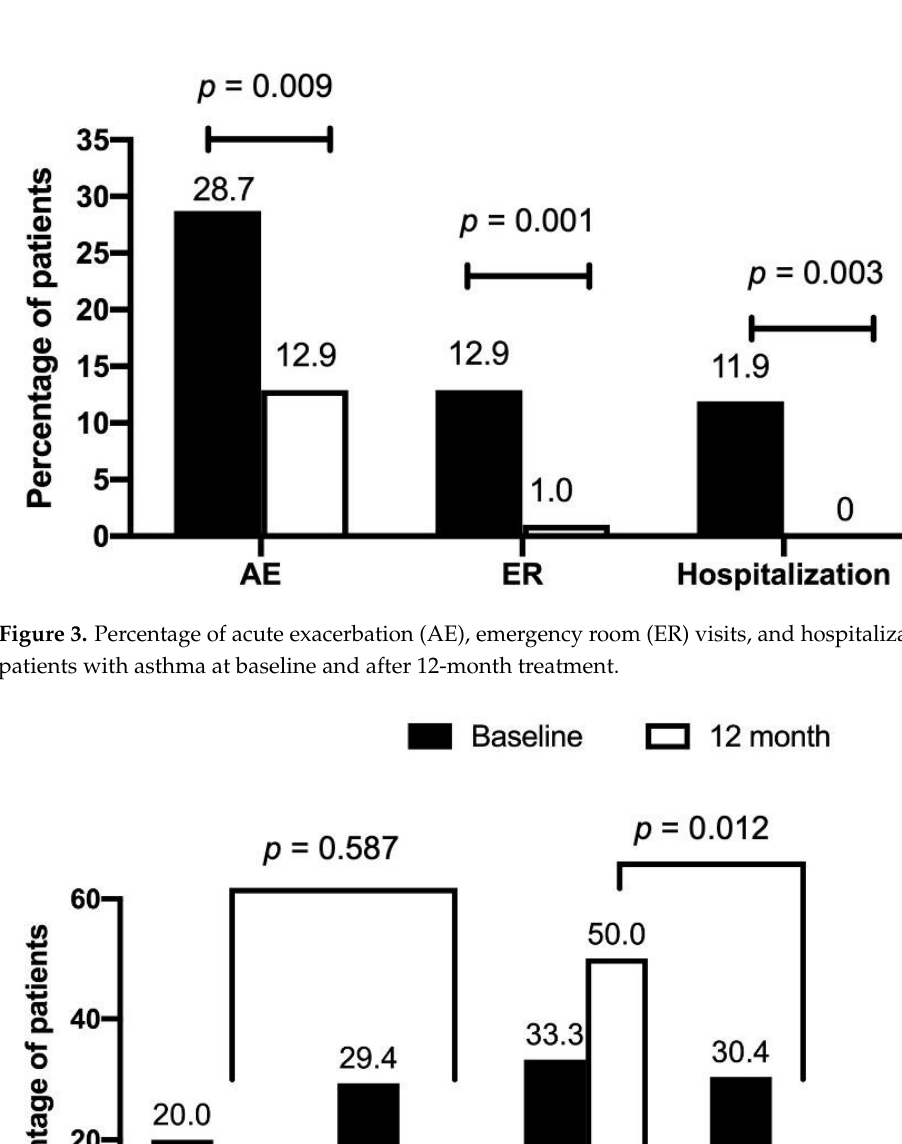
Figure 2. Change of forced vital capacity (FVC) and forced expiratory volume in 1 s (FEV 1 ) in pa- tients with early-onset asthma (EOA) and late-onset asthma (LOA) after 12-month treatment in the total cohort ( A ), patients <65 years old ( B ), and patients ≥ 65 years old ( C ). Boxplots show the median (bar), the first and third quartiles (box), and the 1st and 99th percentiles (whiskers) of the biomarkers level for each asthma status.